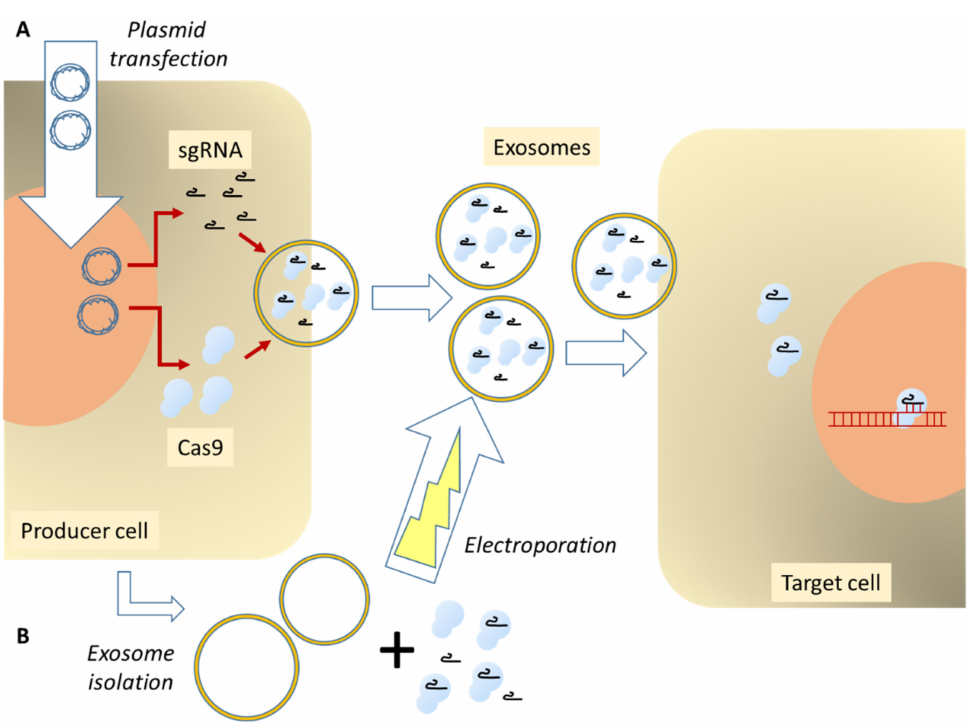
Figure 3. General routes for loading CRISPR/Cas components into EVs. ( A ) By capitalizing on the cellular packaging routines, producer cells can be transfected with plasmids encoding the Cas9 protein and the sgRNA. ( B ) After the isolation and purification of EVs, they are loaded in vitro with Cas9 protein and sgRNAs, e.g., by